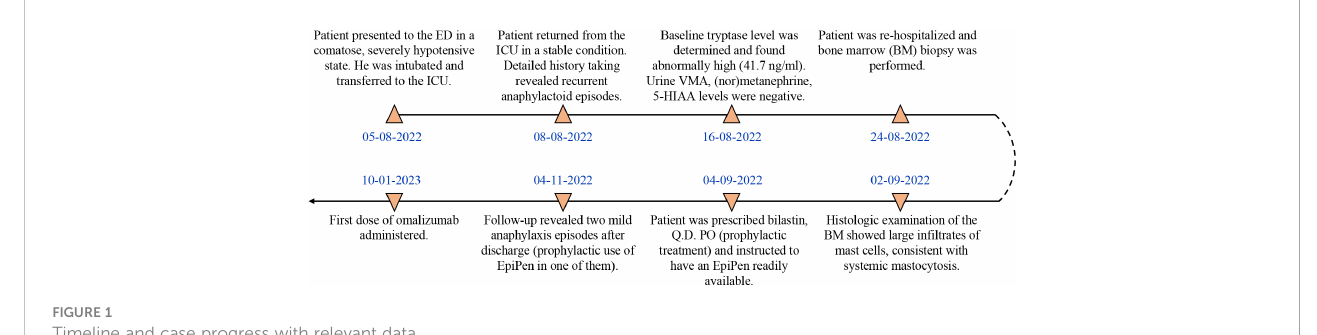
FIGURE 1 Timeline and case progress with relevant